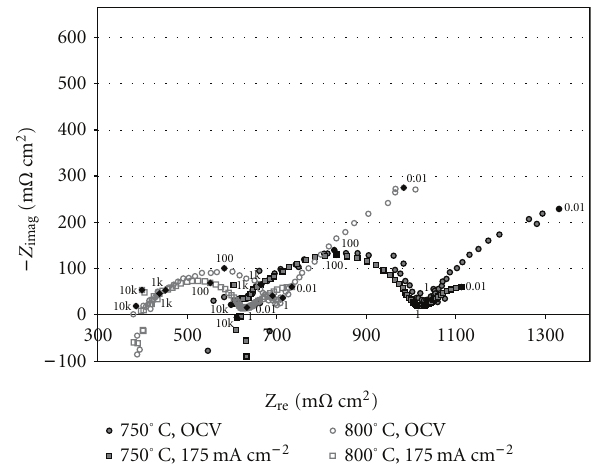
Figure 7: Nyquist plot for a total button cell fed with 97% H 2 and balance H 2 O and operating at varying temperature and load